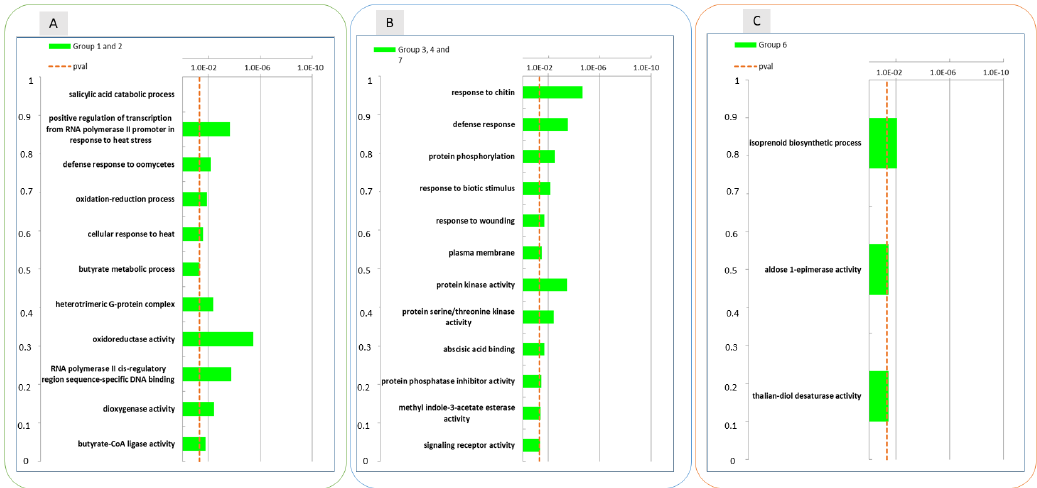
Figure 7. Enrichment analysis of DEGs with similar gene expression patterns identified in the treatment and time interaction using the Gene Ontology database between the groups of DEGs reported in Figure 6: groups 1 and 2 (Panel ( A )), groups 3,4 and 7 (Panel ( B )) and group 6 (Panel ( C )). The data refer to samples collected in